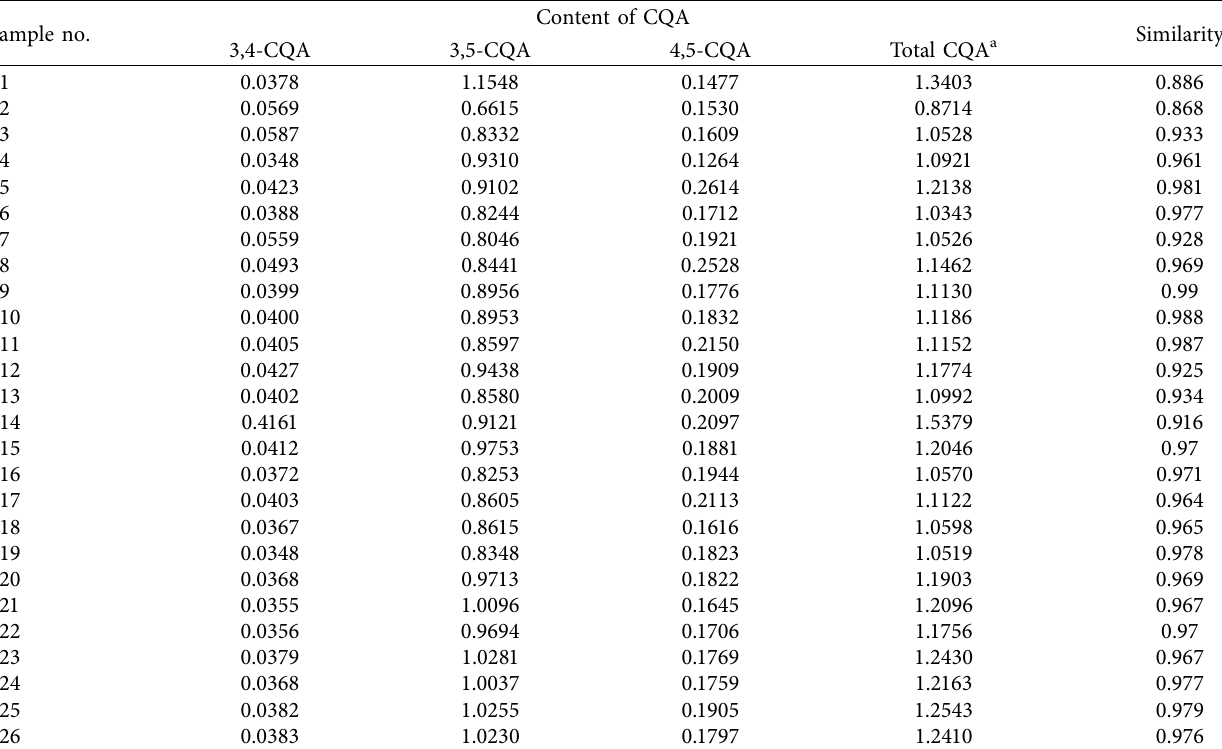
Table 4: Content and similarity of CQAs in 26 samples of V. anthelmintica . Sample no.